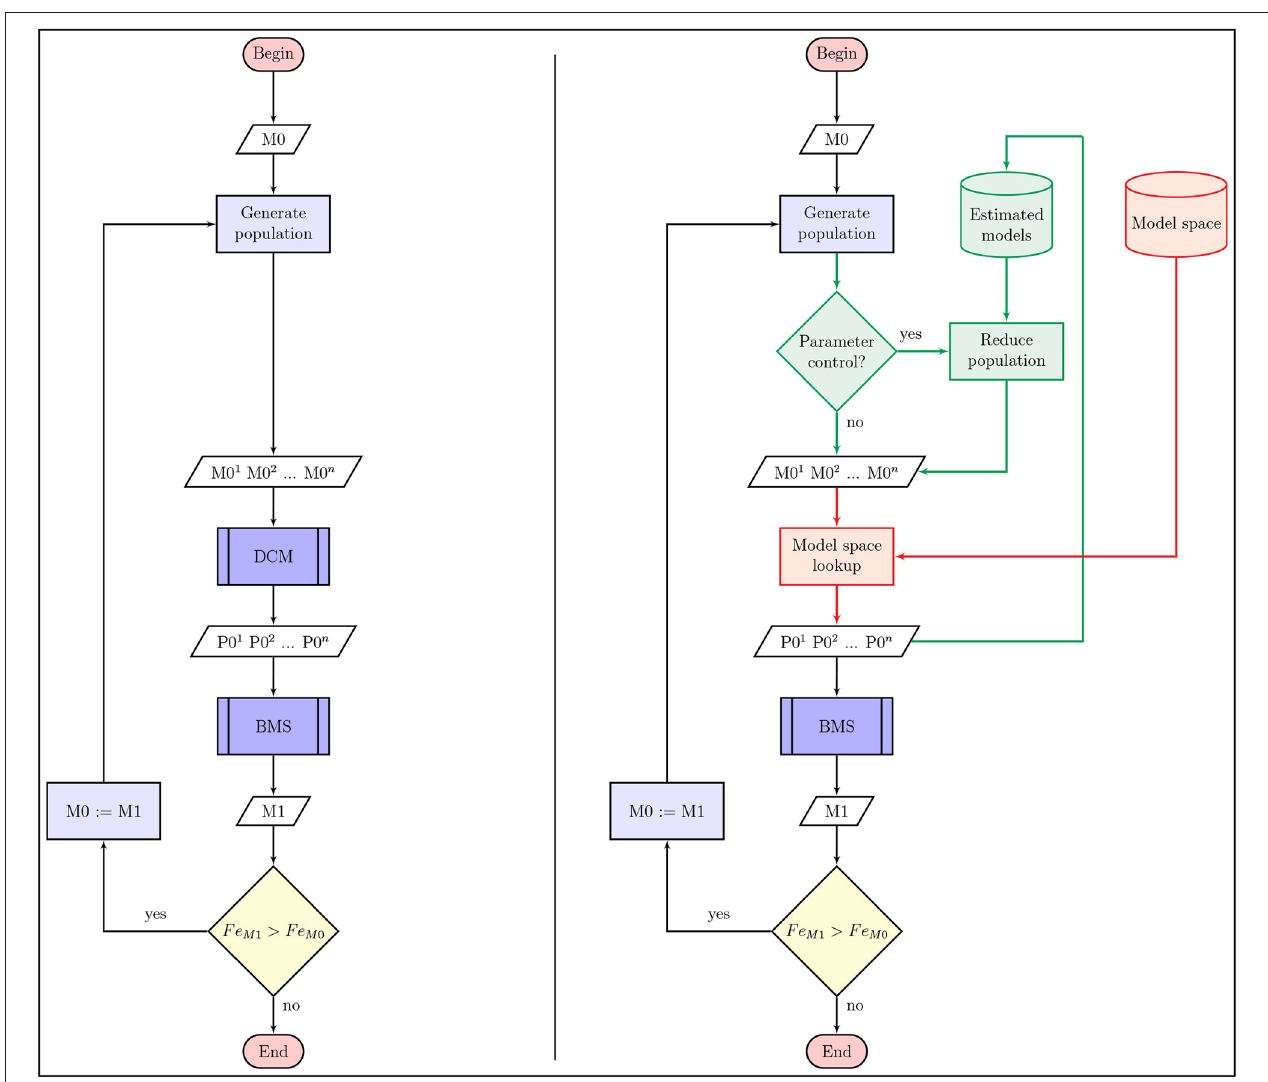
FIGURE 2 | Flowchart of model search algorithms for DCM. The flowchart on the left side panel depicts the most simple schematic of model search methods in a DCM model-space. On the right side we show the changes to the regular procedure that may optimize the algorithm in terms of number of estimated models or search results (green parts), and helps rapid characterization of model search methods using model-space lookup (red parts). In any case the algorithm starts with an initially selected model (or set of models) M 0 that is used to select models M 1 0 , M 2 0 , ... , M n 0 with an arbitrary method for DCM computation. Then we can select the best fitting model (or models) M 1 of the selected population with Bayesian model selection, which is used to generate the next set of models to compare in the next iteration. This procedure continues until we cannot find an improved variation of the previously estimated models. As shown on the right side image, posterior parameter estimates of previously reached models P 1 0 , P 2 0 , ... , P n 0 can also be used to reduce or manipulate the selected population and improve search